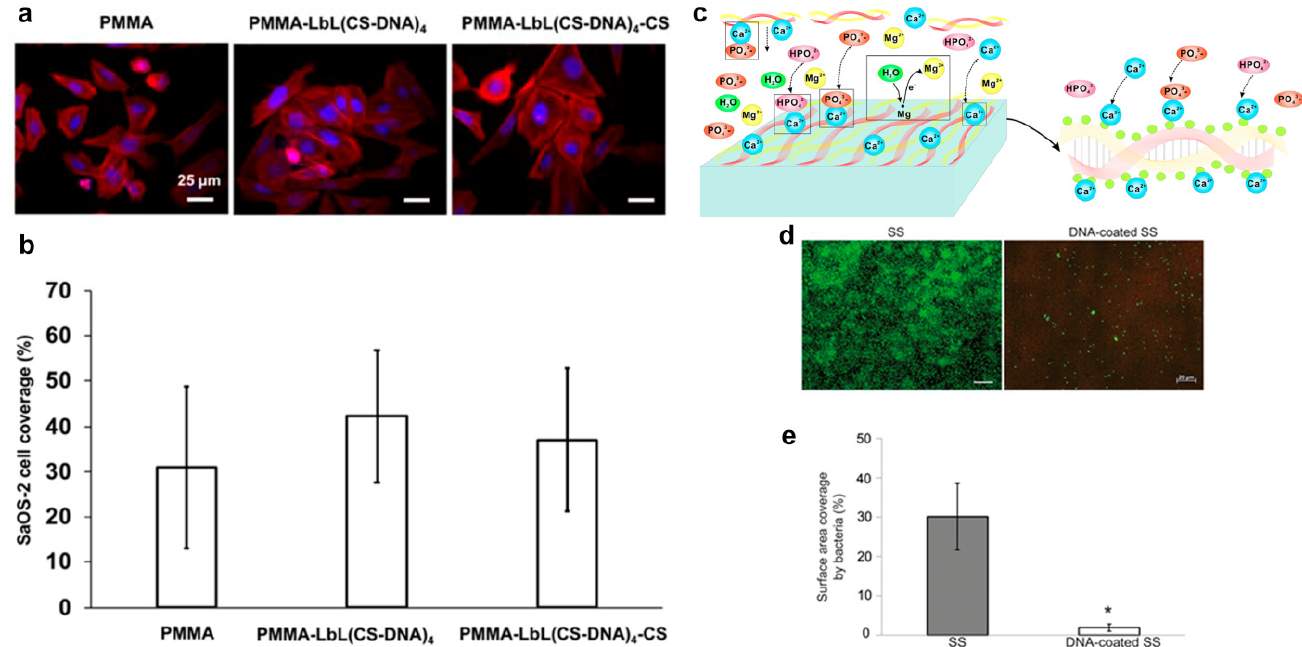
Figure 2. Fluorescent microscopy images of SaOS-2 cells grown on uncoated poly(methyl methacrylate (PMMA) surfaces or PMMA surfaces coated with chitosan/DNA multilayers (PMMA-(CS-DNA) 4 and PMMA-(CS-DNA)4-CS) for 48 h ( a ) and the surface coverage by the cells after 48 h growth ( b ). Reproduced from [58] under the Creative Commons Attribution (CC BY) license (https://creativecommons.org/licenses/by/4.0/). Accessed on 25 November 2021; the mechanism of DNA-induced Ca-P deposition on the surface of Mg alloy (c). Reproduced without modifications from [50] under the CC BY-NC-ND license (http://creativecommons.org/licenses/by-nc-nd/4.0/, accessed on 25 November 2021); the images of SYTO-9-stained bacterial biofilms adhered to stainless steel surfaces after 48 incubation obtained by fluorescent microscopy (scale bar is 20 µm) ( d ) and the surface coverage by the bacteria after 48 h growth ( e ). A statistically significant decrease in bacterial adhesion to DNA-coated surface compared to the uncoated one is indicated by an asterisk. Reproduced with permission from [59]. Copyright 2019 Taylor & Francis.